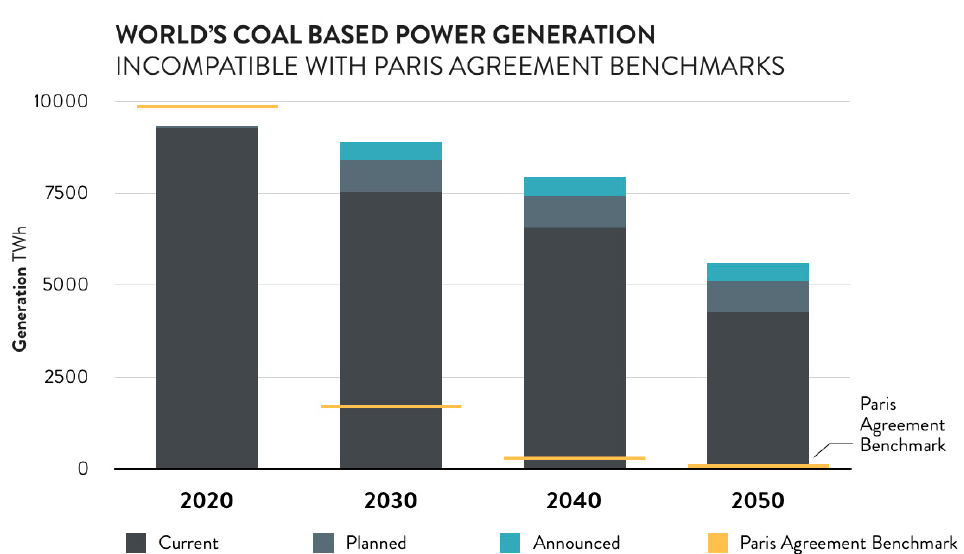
Figure 9. Future coal generation from current and planned coal power plants against Paris Agreement benchmarks, Reproduced with permission from Climate Analytics [26].